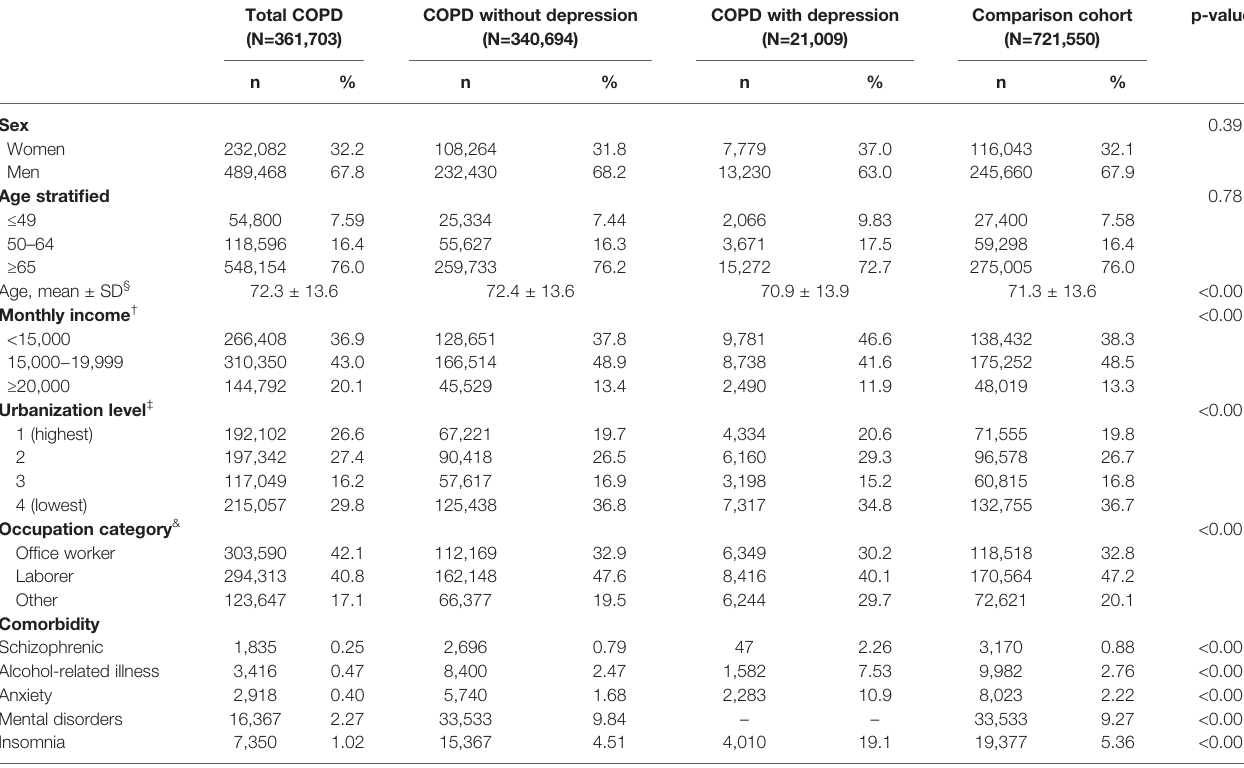
TABLE 1 | Distribution of demographic characteristics and comorbidities among COPD cohorts and the comparison cohort. Total COPD COPD without depression COPD with depression (N=361,703) (N=340,694)